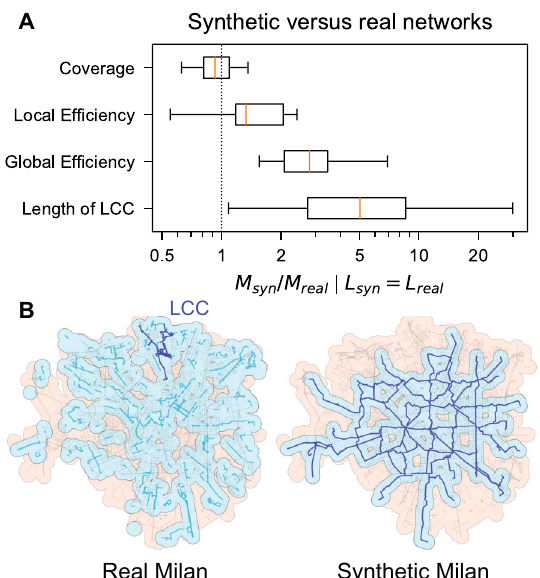
Figure 6. Synthetic bicycle networks perform several times better than existing ones. ( A ) We plot the distributions (over cities) of the ratios M syn / M real between network metrics of synthetic and existing topologies fixed at same length ( L syn = L real ), for betweenness growth and grid seeds (for all other growths see Supplementary Fig. 2). Synthetic networks have on average 5 times larger LCCs, 3 times the global efficiency, and higher local efficiency. Existing networks only tend to have better coverage because they are more scattered. ( B ) Illustration of high coverage (light blue area) due to extreme scattering and low length of LCC (dark blue sub-network) for Milan’s existing bicycle network, versus its synthetic version at same length ( 185 km at q B = 0.425 ). The LCC for synthetic Milan is the whole network. Maps created with: https:// github. com/ mszell/ biken wgrow th